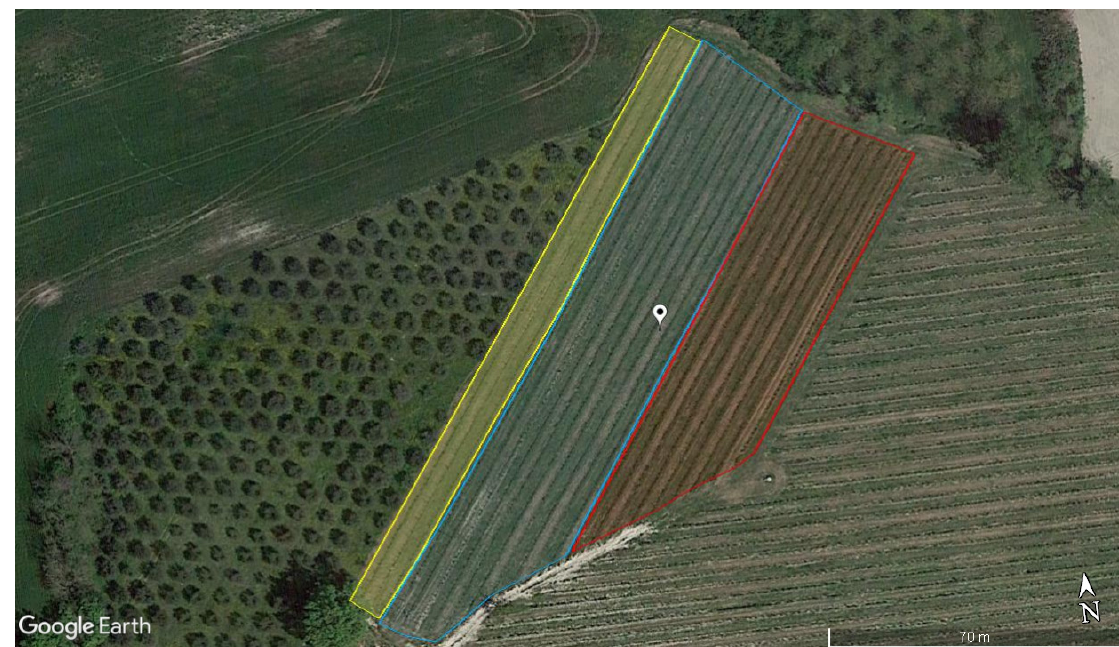
Figure 2. Experimental design of the vineyard: control in yellow, LiDAR test in blue and standard test in red. Table 1. Experimental vineyard mapping.